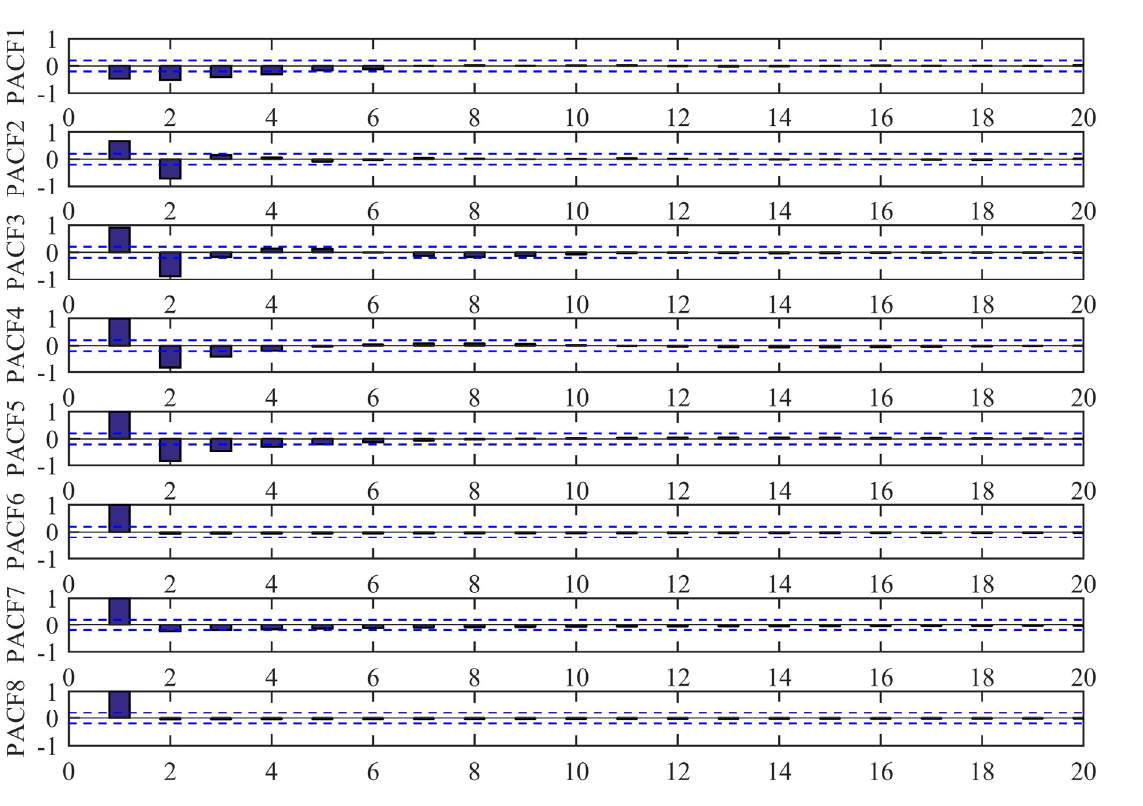
Figure 8. The PACF of IMFs and one residue of the wind